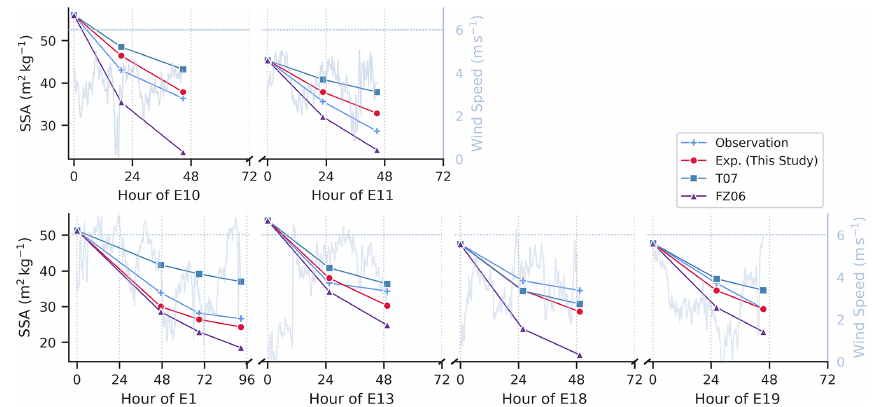
Figure A5. SSA decay model evaluation and a comparison with observations. Included models are the decay model from this study and the existing decay models from Flanner and Zender (2006), FZ06, and Taillandier et al. (2007), T07. The 10min averaged wind speed is shown on the secondary y axis, with the 6m 2 kg − 1 thresholds indicated. Low-wind events E10 and E11 are shown in the upper panel, and moderate-wind events are shown in the lower panel (E1, E13, E18 and E19).